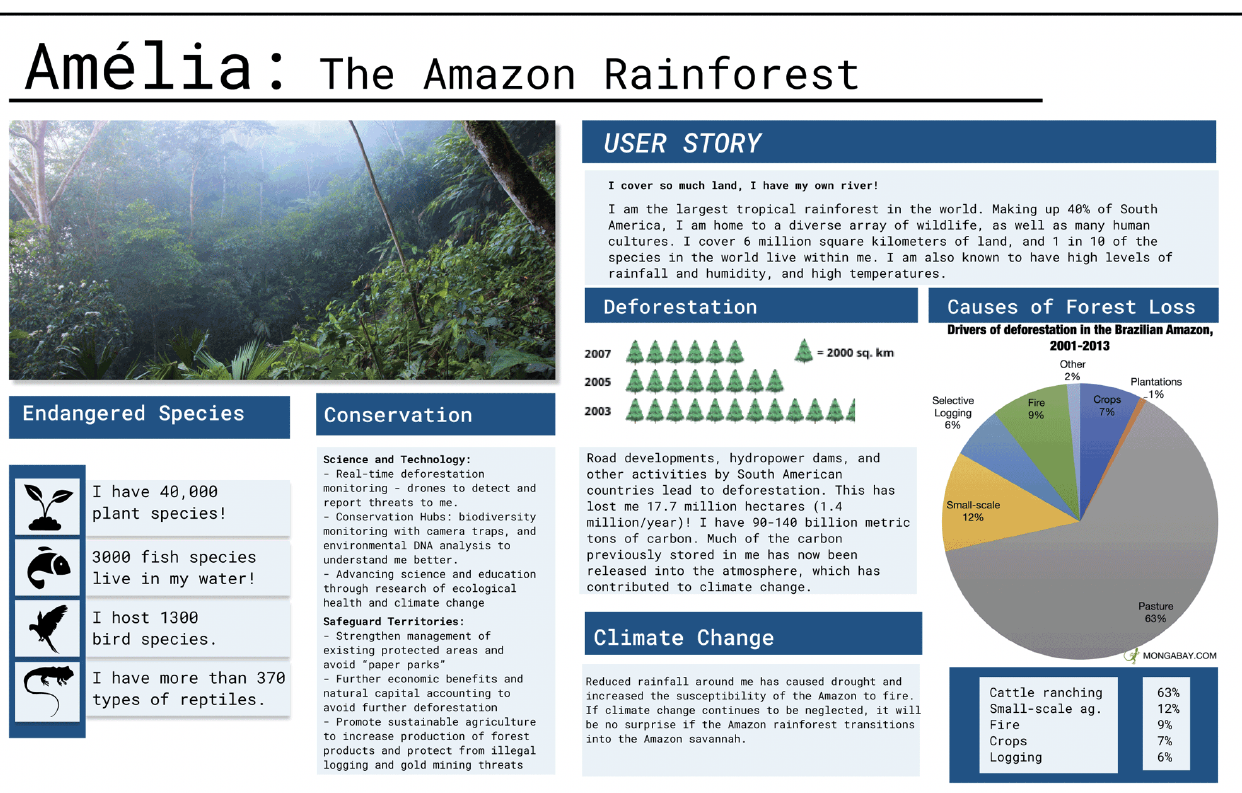
Fig. 2 . An anthropomorphized ecosystema based on the Amazon Rainforest. The rainforest is given a name, the user story and other elements are written from a first person point of view, with more personal content. Material in this ecosystema, including images, were drawn from Figueiredo 2007, WWF 2014, 2020, 2022, Global Environment Facility 2021, Sengupta et al. 2021, Amazon Conservation Association 2022, Climate Institute 2022, Conservation International 2022; Jay 2015, https://commons.wikimedia.org/ wiki/File:Amazon_Rainforest_in_Tena,_Ecuador.jpg; Butler 2021, https://rainforests.mongabay.com/amazon/amazon_destruction.